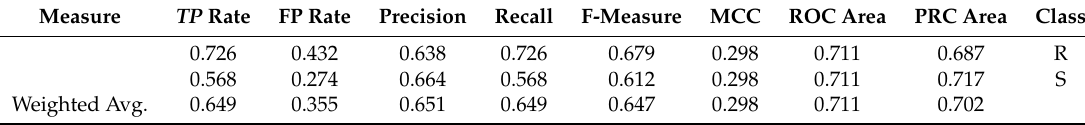
Table 6. Detailed accuracy by class of lB5 (5 nearest neighbor) (10-fold cross-validation).